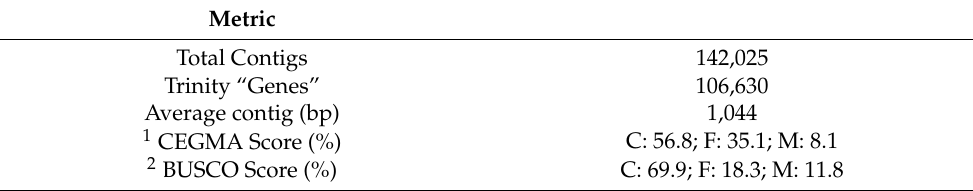
Table 1. Summary of the de novo transcriptome metrics and annotation